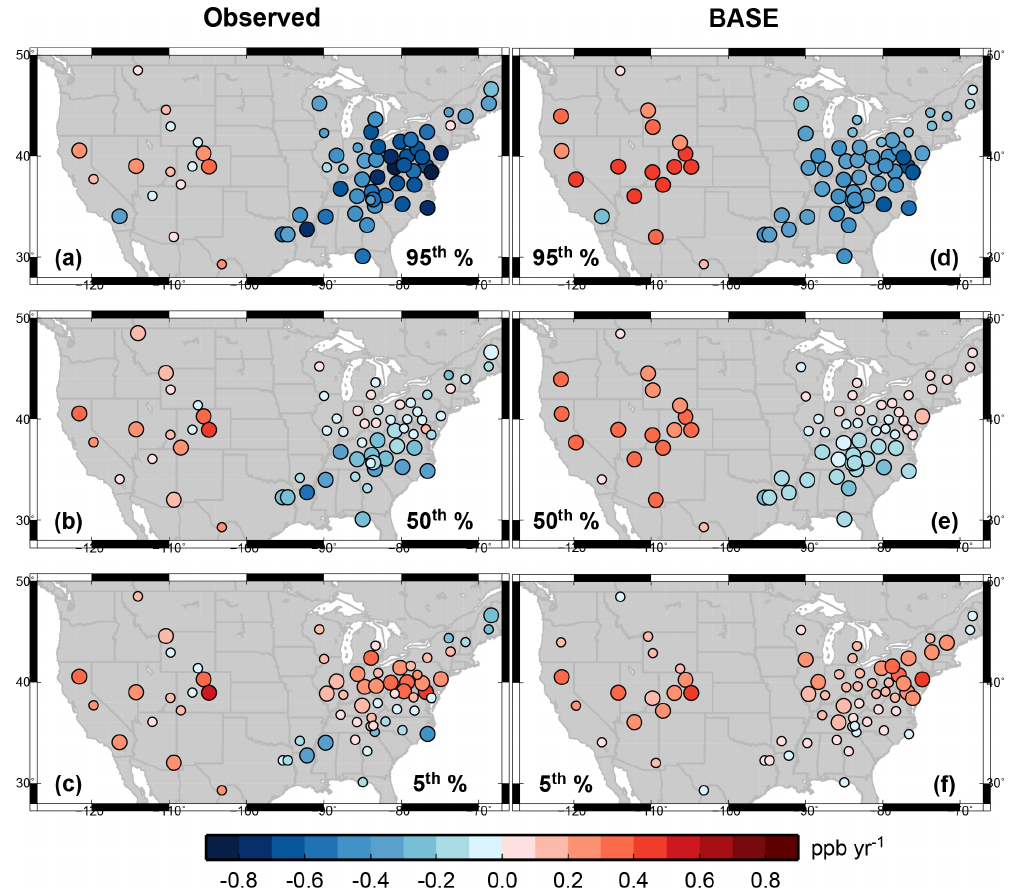
Figure 7. Linear trends in spring (MAM) MDA8 O 3 over 1988–2014 at US rural sites for the 95th, 50th, and 5th percentiles as observed (left) and simulated (right) in AM3 BASE. Larger circles indicate sites with statistically significant trends ( p <0.05). For WUS high-elevation sites, the model is sampled at 700hPa and filtered to remove local influence (see text in Sect.